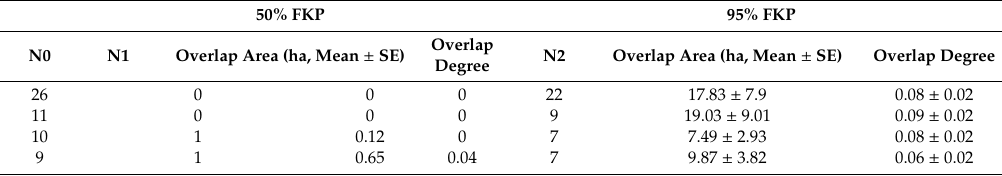
Table 2. Site fidelity of black-necked crane among four breeding stages (mean ± SE). FKP, fixed-kernel polygons; PI, preincubation; IN, incubation; PF, postfledging; and FF, fully fledged. Table 1. Home-range overlap areas of neighboring Black-necked Cranes. FKP, fixed-kernel polygons; PI, preincubation; IN, incubation; PF, postfledging; FF, fully fledged; N0, number of neighboring families (nonrepetitive counting); and N1 and N2 numbers of neighboring families with overlapping areas.